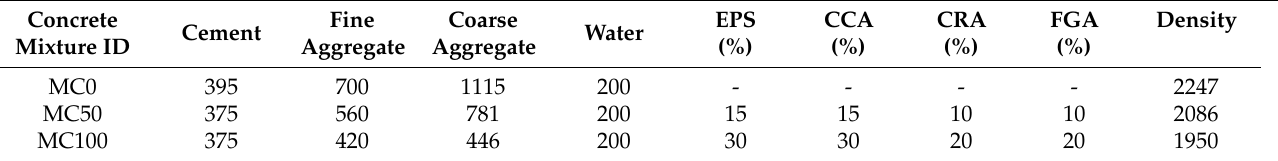
Table 3. Physical properties of the tested materials.